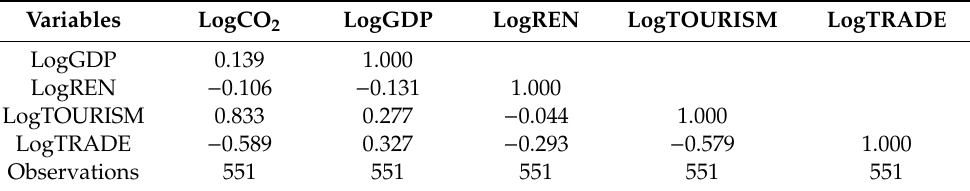
Table 2. Correlations between variables.